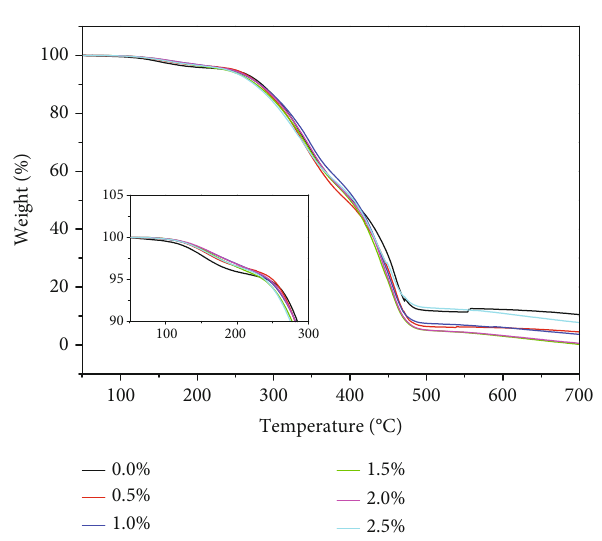
Figure 9: (a) TG and (b) DTG curves of the 10-UA-Tb(III) complex.